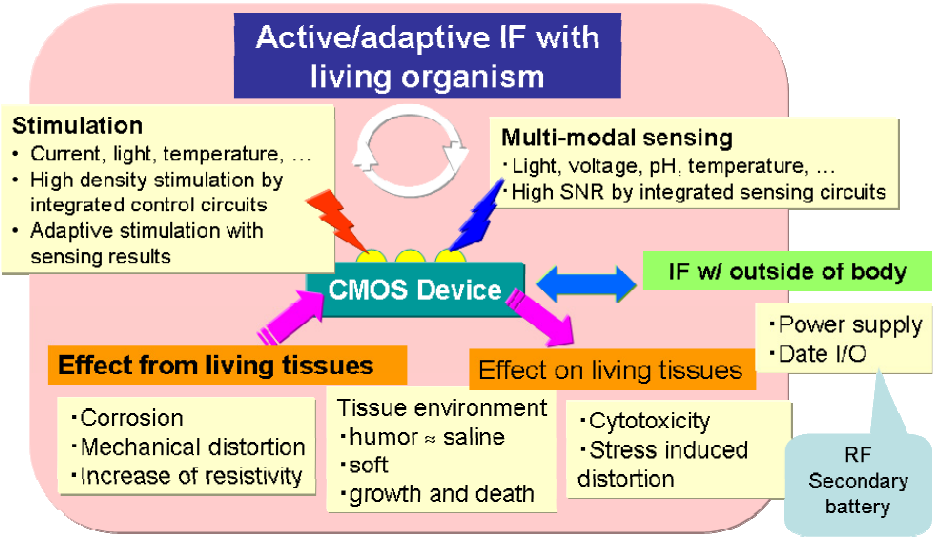
Figure 1. Advantages and problems associated with in vivo implantation of CMOS